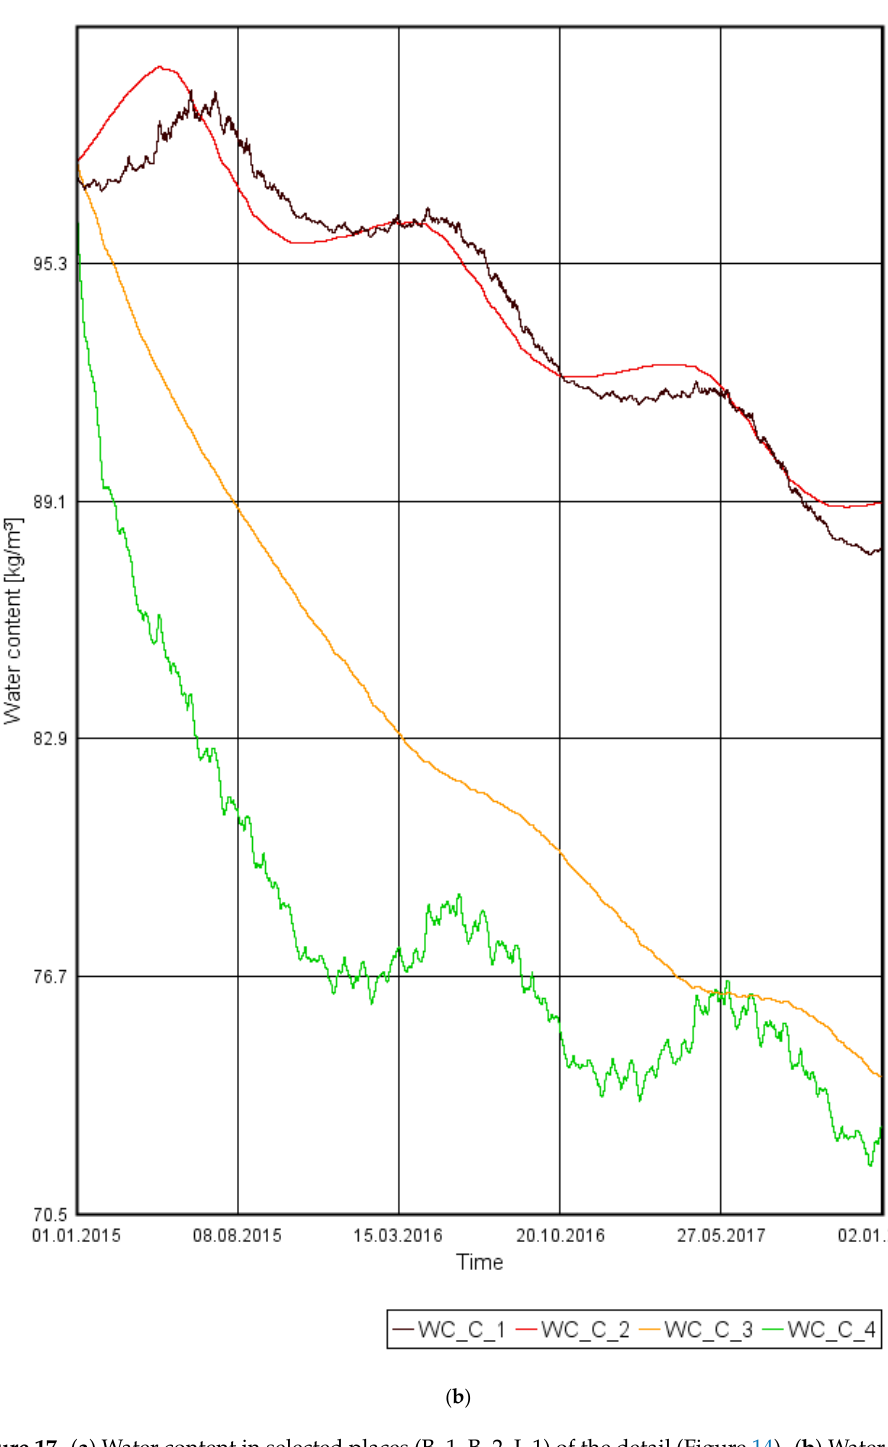
Figure 18. ( a ) Water content in selected places (B_1, B_2, J_1) of the detail (Figure 14). ( b ) Water content in selected places (C_1 ‐ C_4) of the detail (Figure 14).